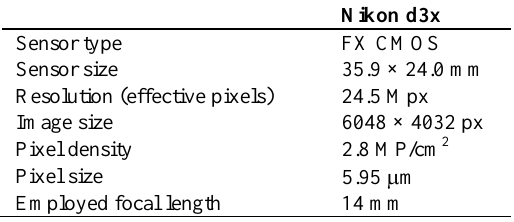
Table 3. Digital camera technical specifications.